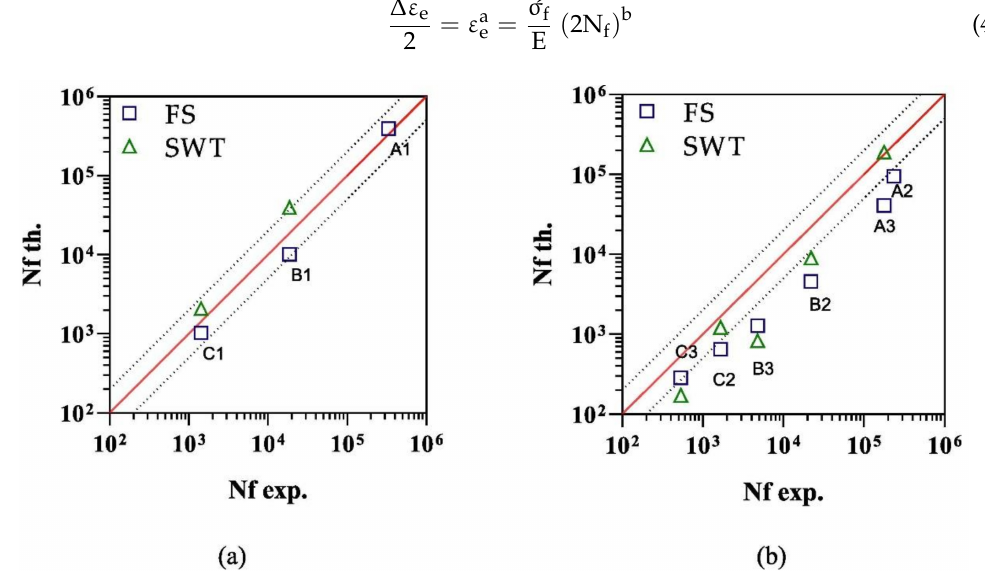
Figure 13. Fatigue life estimation of Fatemi–Socie and Smith–Watson–Topper and critical plane models contrasted with the experimental life found for 18Ni300 steel. ( a ) Unnotched specimen, ( b ) notched specimen. Reprinted with permission from ref. [71]. 2022, Elsevier.